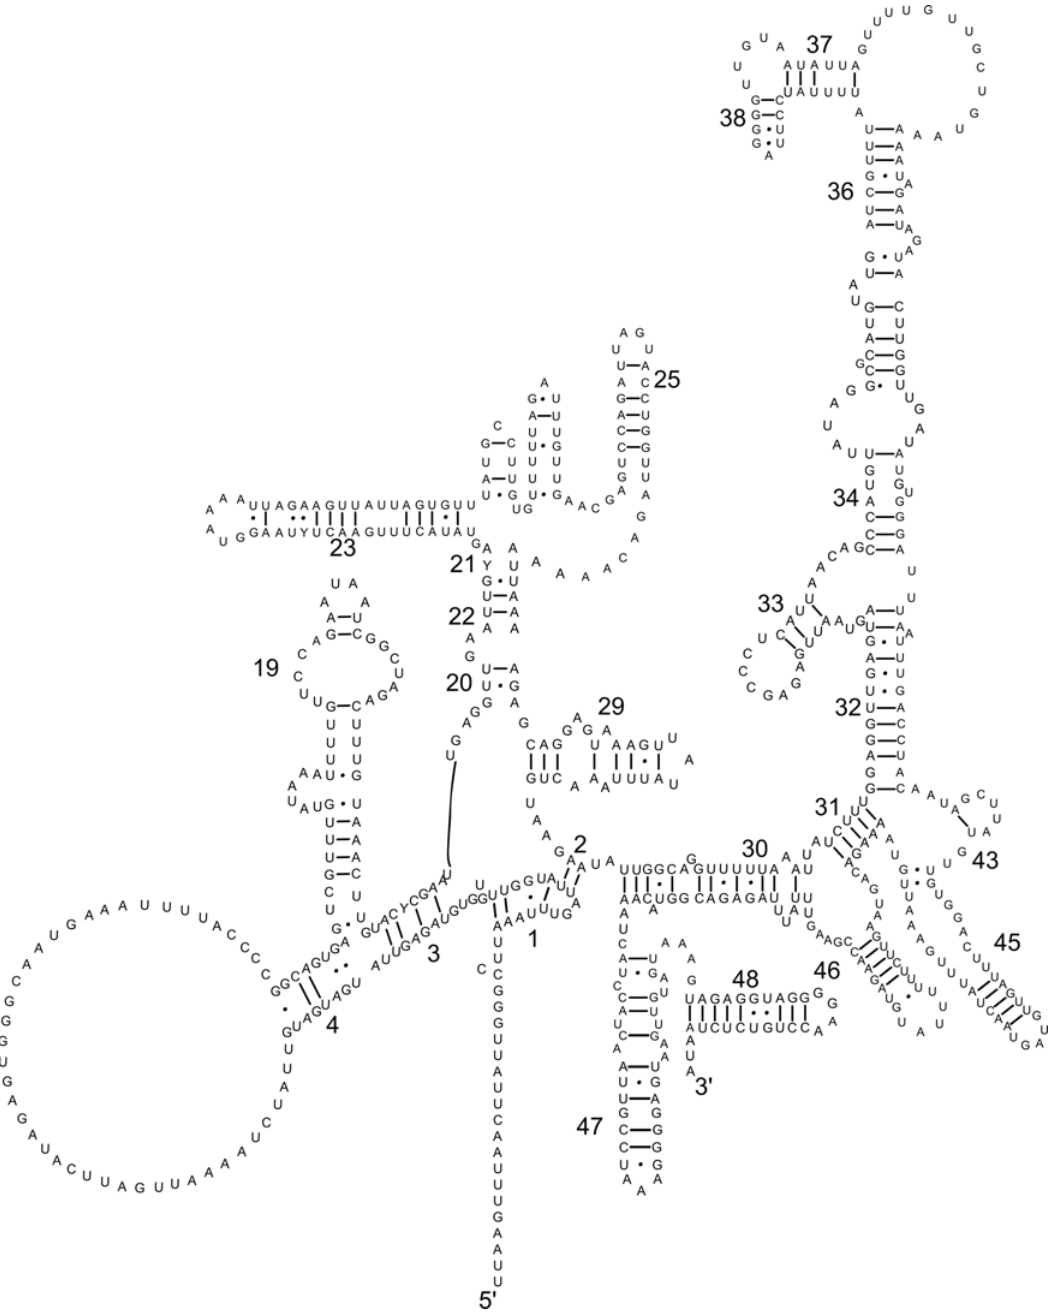
Figure 4. The secondary structure predicted for the small subunit ( rrn S) of the rRNA gene in the mitochondrial genome of Toxocara canis . Bonds between C:G and U:A are indicated by a straight line and those between U:G by a closed circle [35]. Conserved secondary structure elements [102] indicated by numbers 1–48.